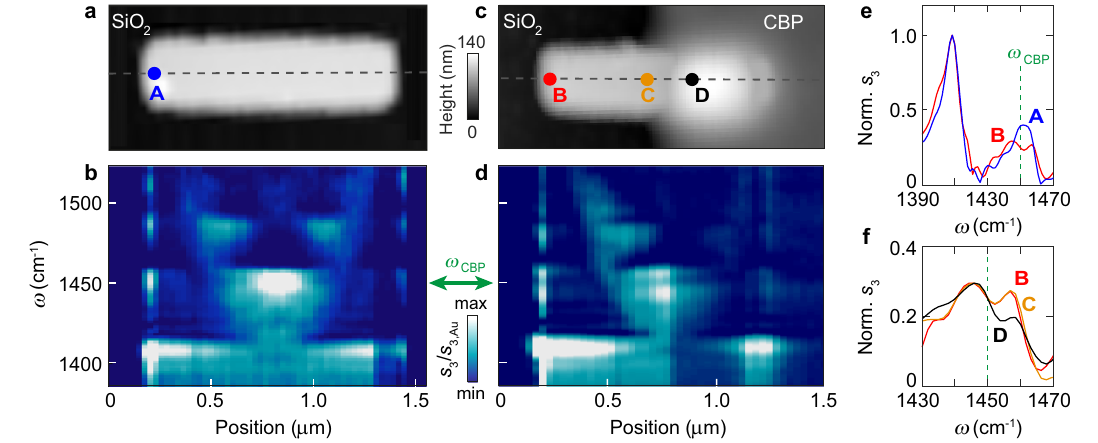
Fig. 2 | Nano-FTIR line scans of bare and half molecule-covered h-BN nanor- esonators. a Topography image of a bare h-BN nanorod of 1.25 μ m length, 110nm height and 250nm width. b Nano-FTIR amplitude spectra recorded along the horizontaldashedblacklineinpanel a . c Topographyimageofanh-BNnanorodof 1.1 μ m length, 87nm height and 250nm width, which is half covered with a 50nm thick CBP layer. d Nano-FTIR amplitude spectra recorded along the horizontal dashed black line in panel c . e Nano-FTIR amplitude spectra of the bare (blue) and